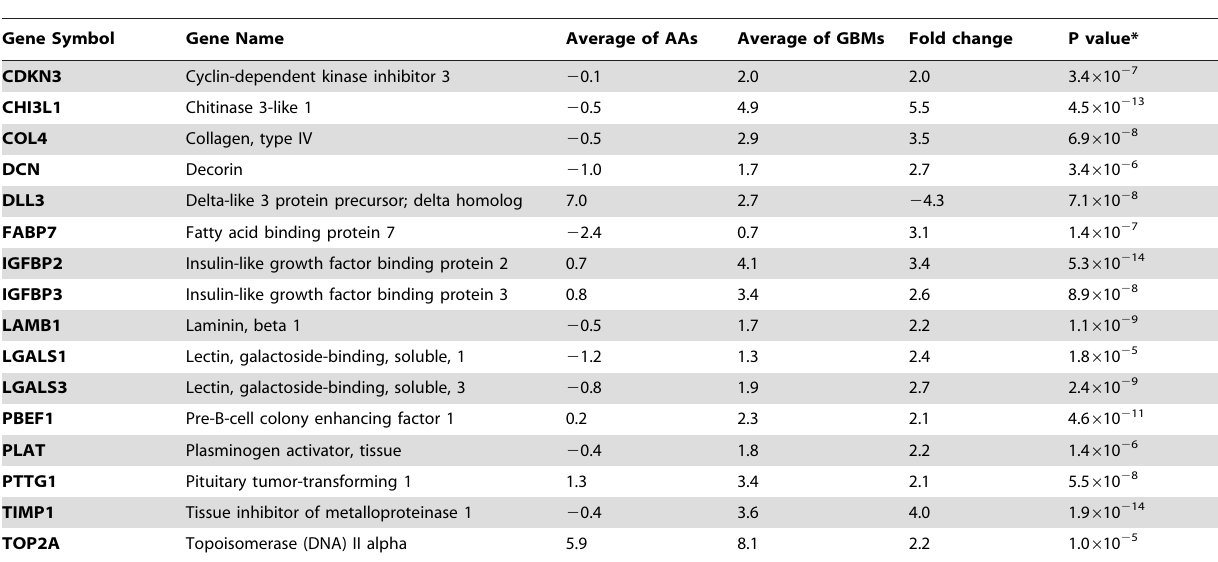
Table 1. Expression of 16 genes selected from PAM in AA (n=30) and GBM (n=78) samples of the training set.